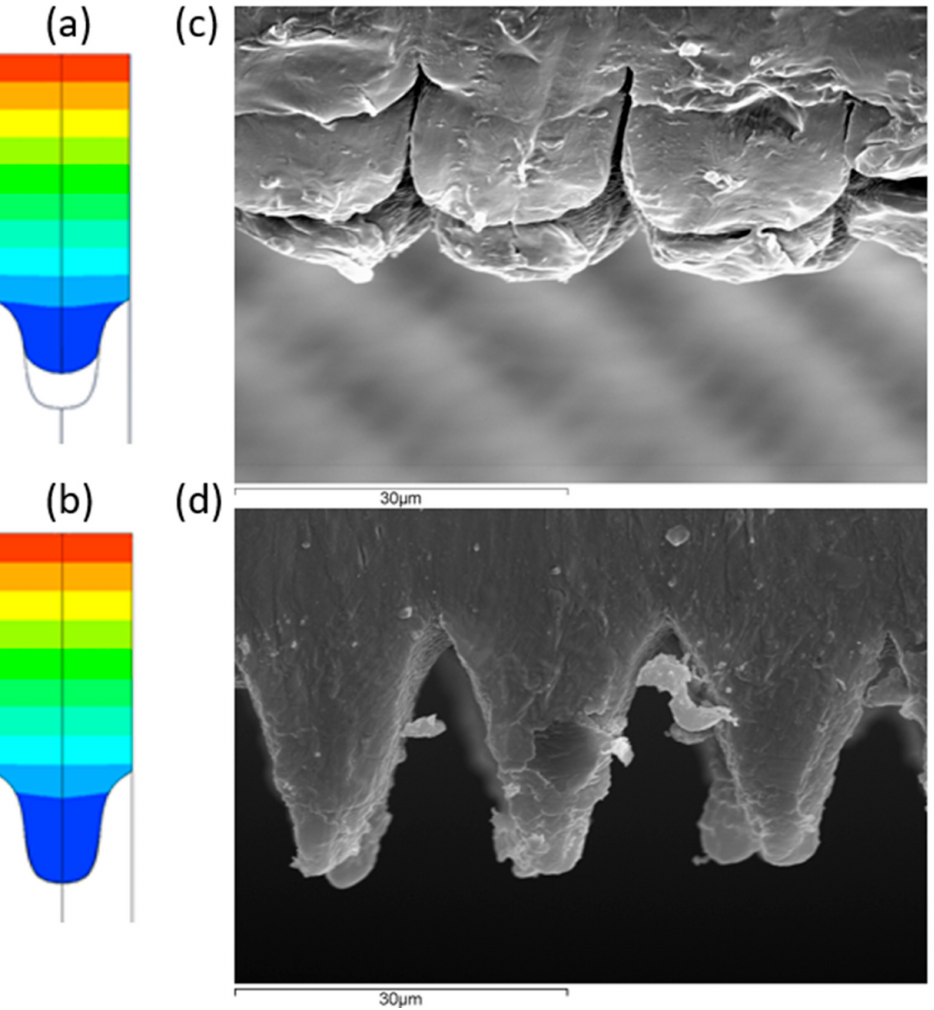
Figure 8. Simulation at ending time (15 s) on conditions ( a ) T = 230 ◦ C, Tm = 30 ◦ C and ( b ) T = 270 ◦ C, Tm = 90 ◦ C and SEM micrograph ( c ) T = 230 ◦ C, Tm = 30 ◦ C and ( d ) T = 270 ◦ C, Tm = 90 ◦